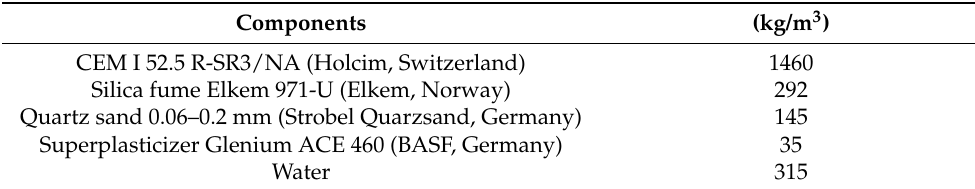
Table 2. Composition of the concrete matrix